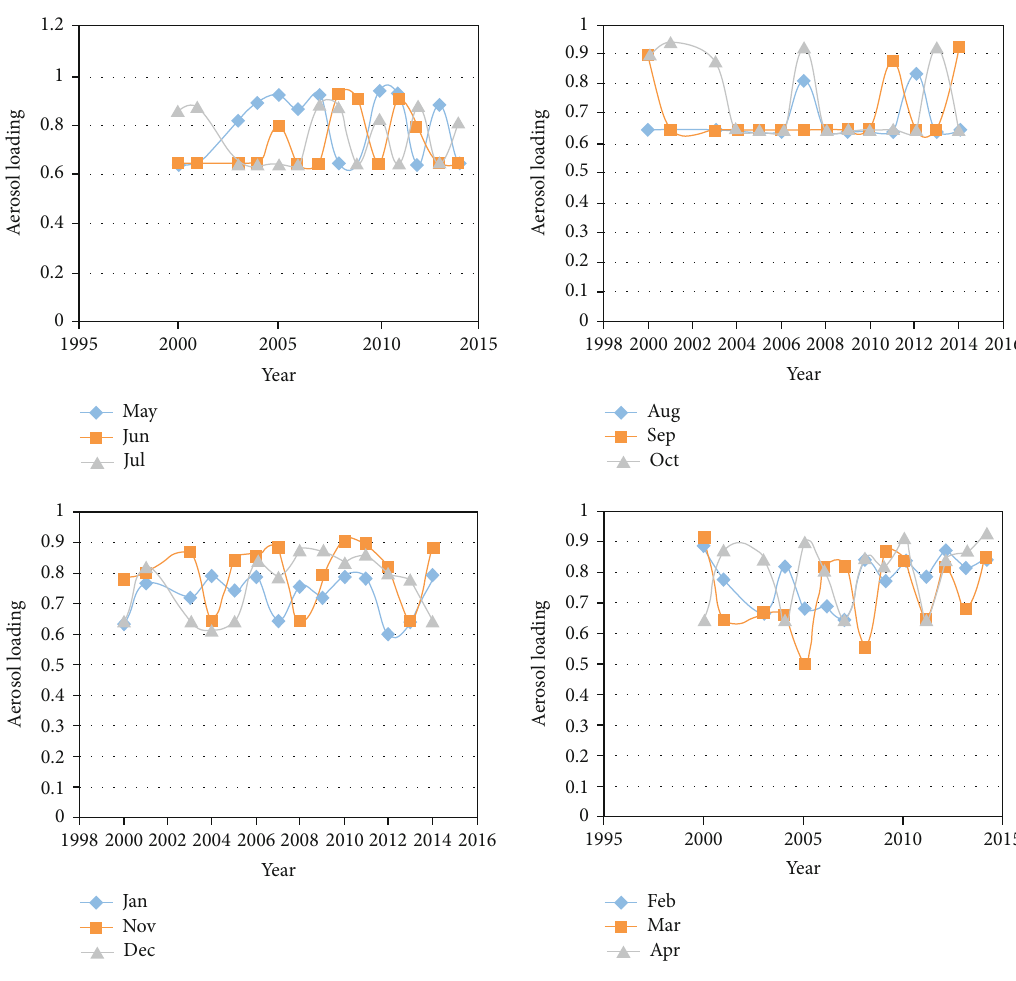
Figure 11: Aerosol loading within four